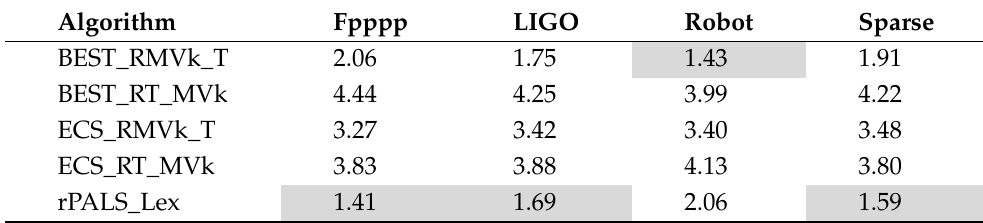
Table 14. Makespan Friedman rankings